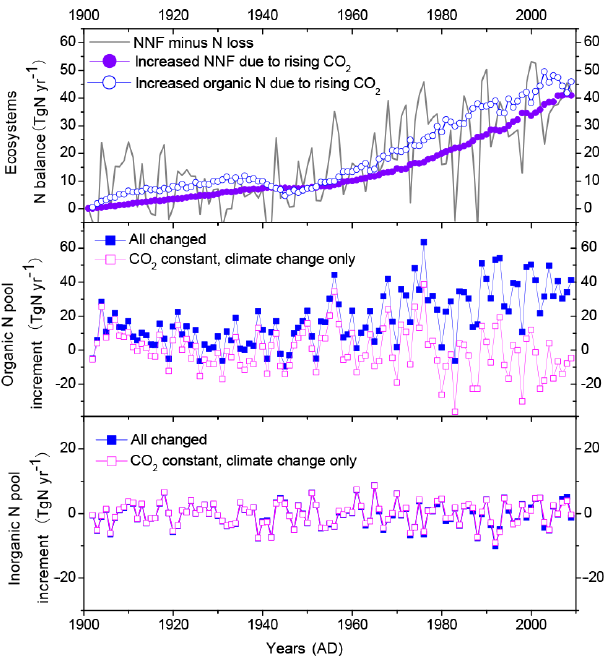
Figure 6. Transient simulations during the 20th century, with e = 0 . 175 and changes in CO 2 and climate or in climate alone. (a) Ecosystem N balance. (b) Organic N pool. (c) Inorganic N pool.